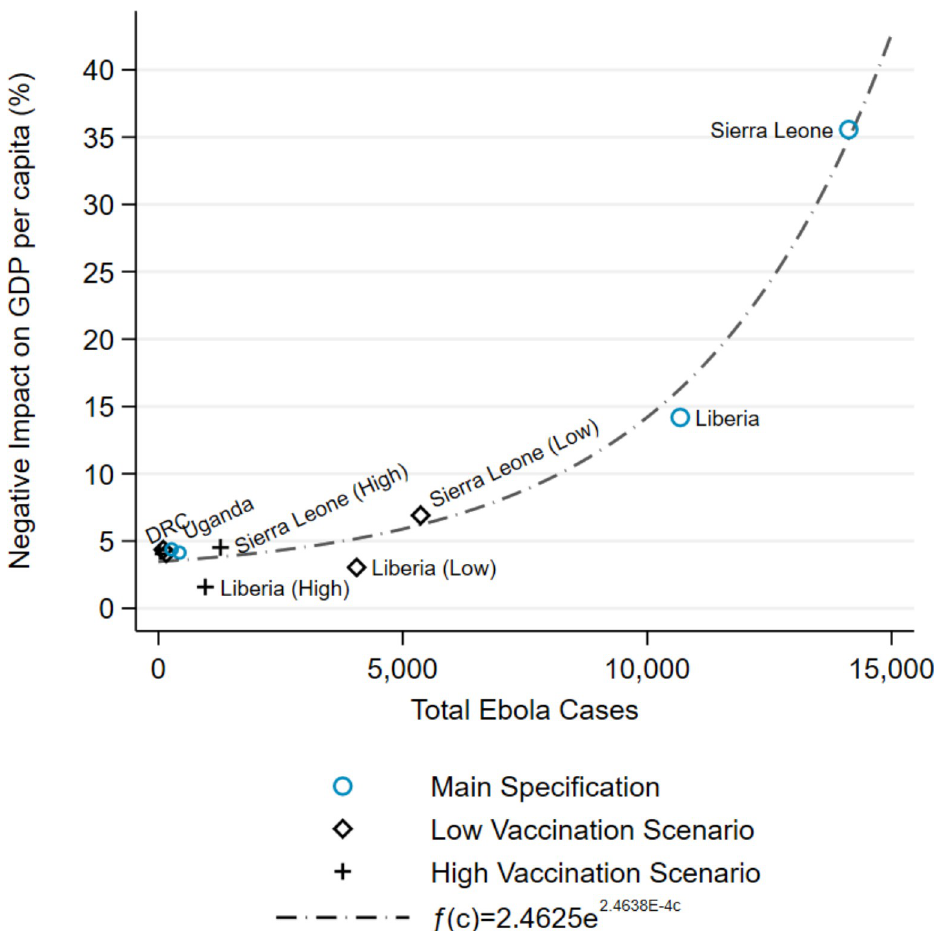
Fig 3. Function describing the relationship between Ebola cases and GDP impact. DRC, Democratic Republic of the Congo; GDP, gross domestic product.